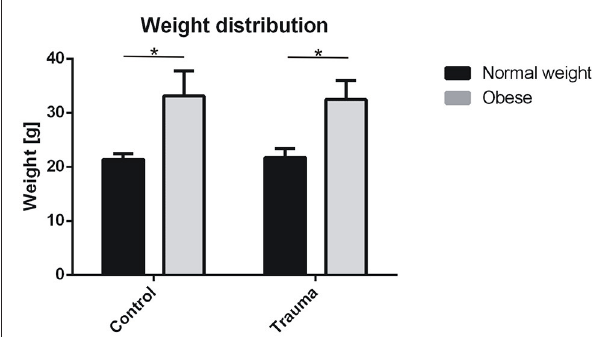
FIGURE 1 | Body weight of animals and significant differences of our cohort. Values are given with mean ± standard deviation; n = 18 per group. Statistical analysis by two-sided homoscedastic t -test. *Indicates p ≤ 0.01.